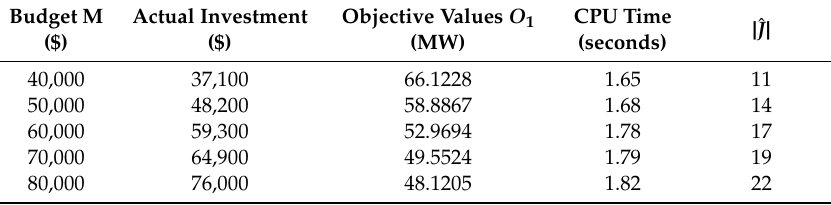
Table 1. Results of the proposed approach on the IEEE 118-bus system.